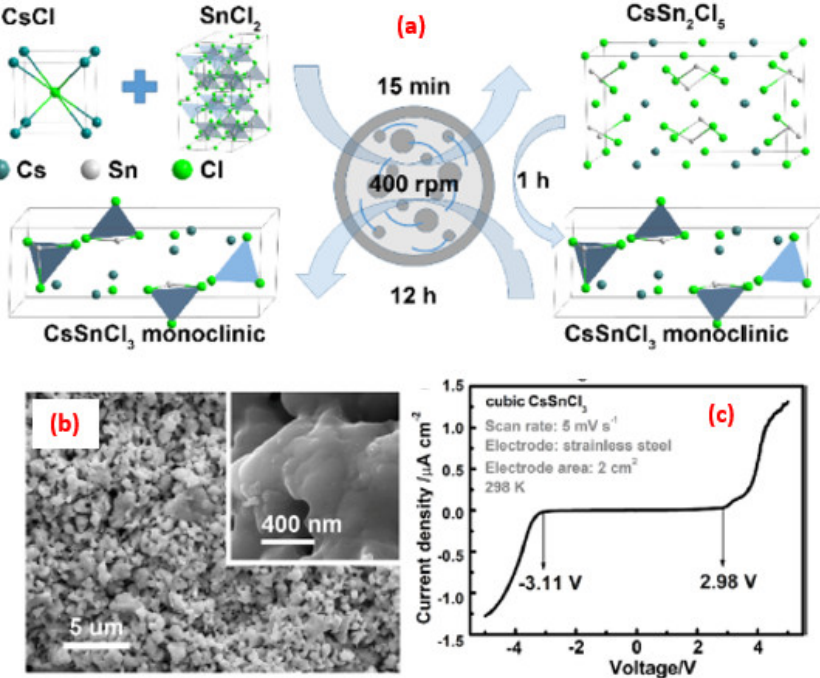
Figure 10. ( a ) Schematic figure shows the fabrication process of the monoclinic CsSnCl 3 material; ( b ) SEM image of the as-prepared monoclinic CsSnCl 3 material; and ( c ) Linear sweep voltammetry scan (5 mV s −1 ) of the cubic MM−1 h-HT electrolyte at 298 K. Copyright 2020 by the American Chemical Society [111].